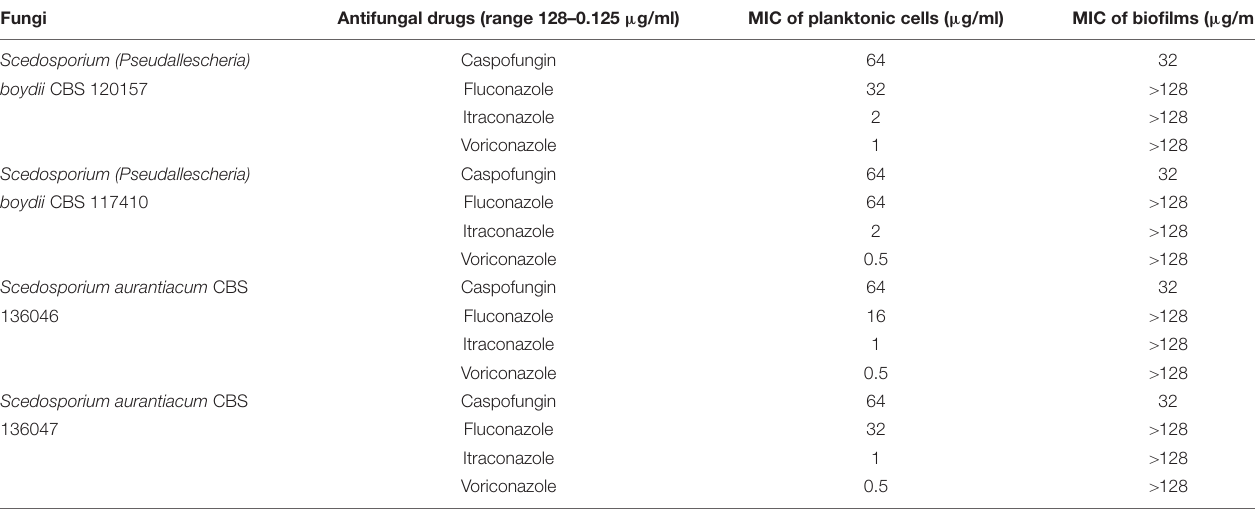
TABLE 2 | The minimum inhibitory concentration (MIC) of different antifungal drugs used to treat S. boydii and S. aurantiacum planktonic cells and biofilms.